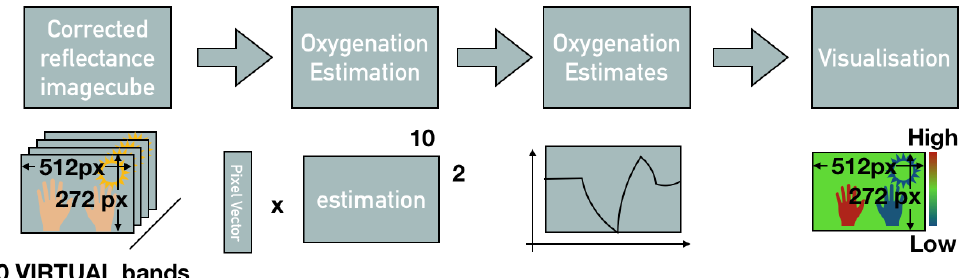
Figure 8. Oxygenation estimation from spectral reflectance